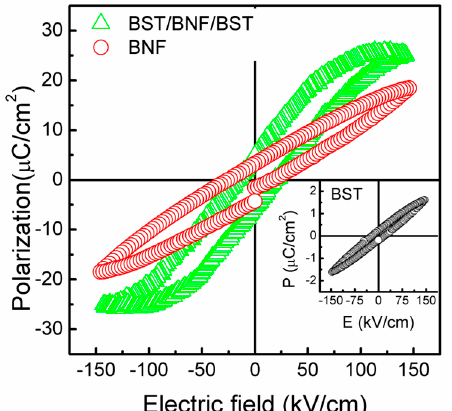
Figure 4. The typical P – E hysteresis loops for the BNF and BST/BNF/BST films on Pt/(111)Ti/SiO 2 /Si(100) substrate at room temperature and 250 Hz, the inset is the P – E hysteresis loop of single layer BST thin film.